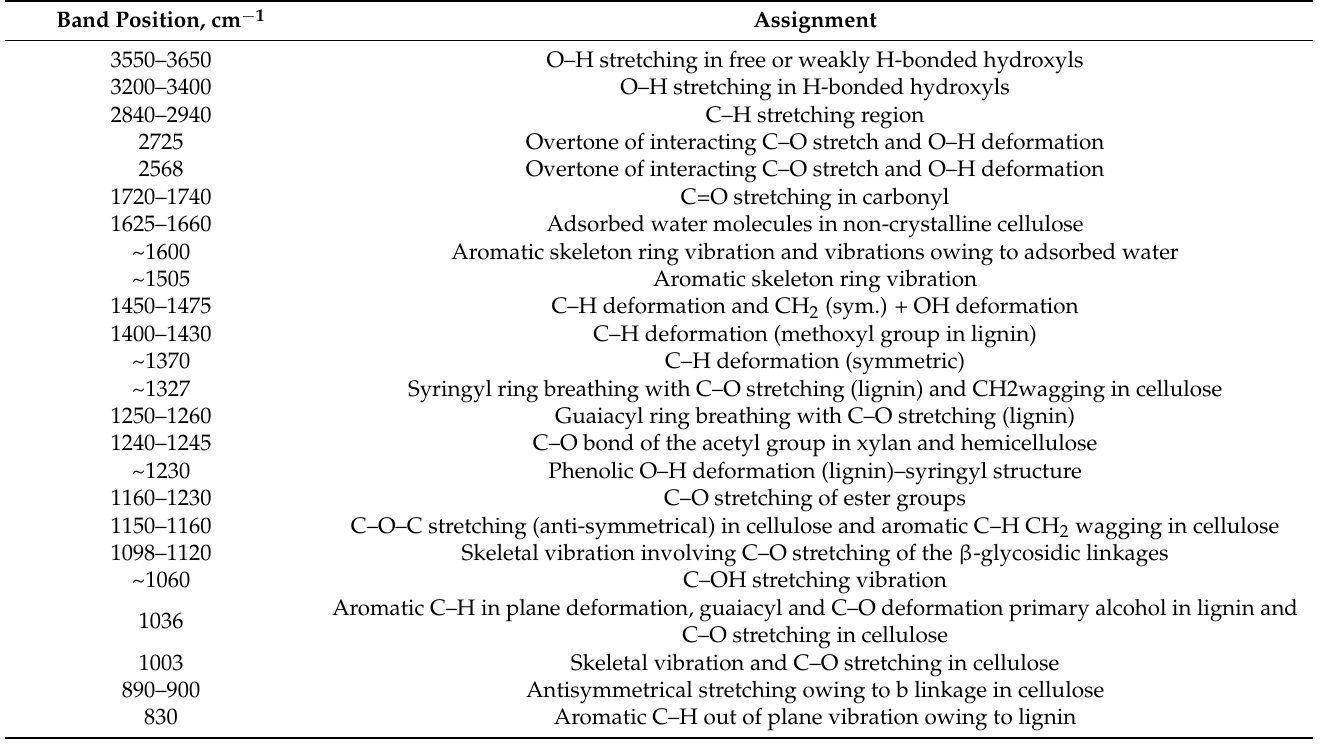
Table 4. Peak assignments of the lignocellulosic materials